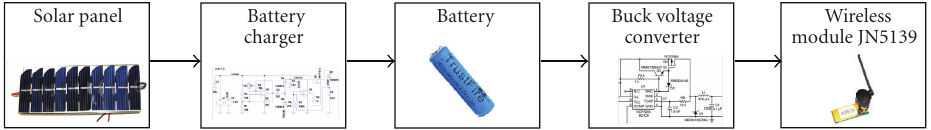
Figure 9: Block diagram of the functional unit of alternative power supply